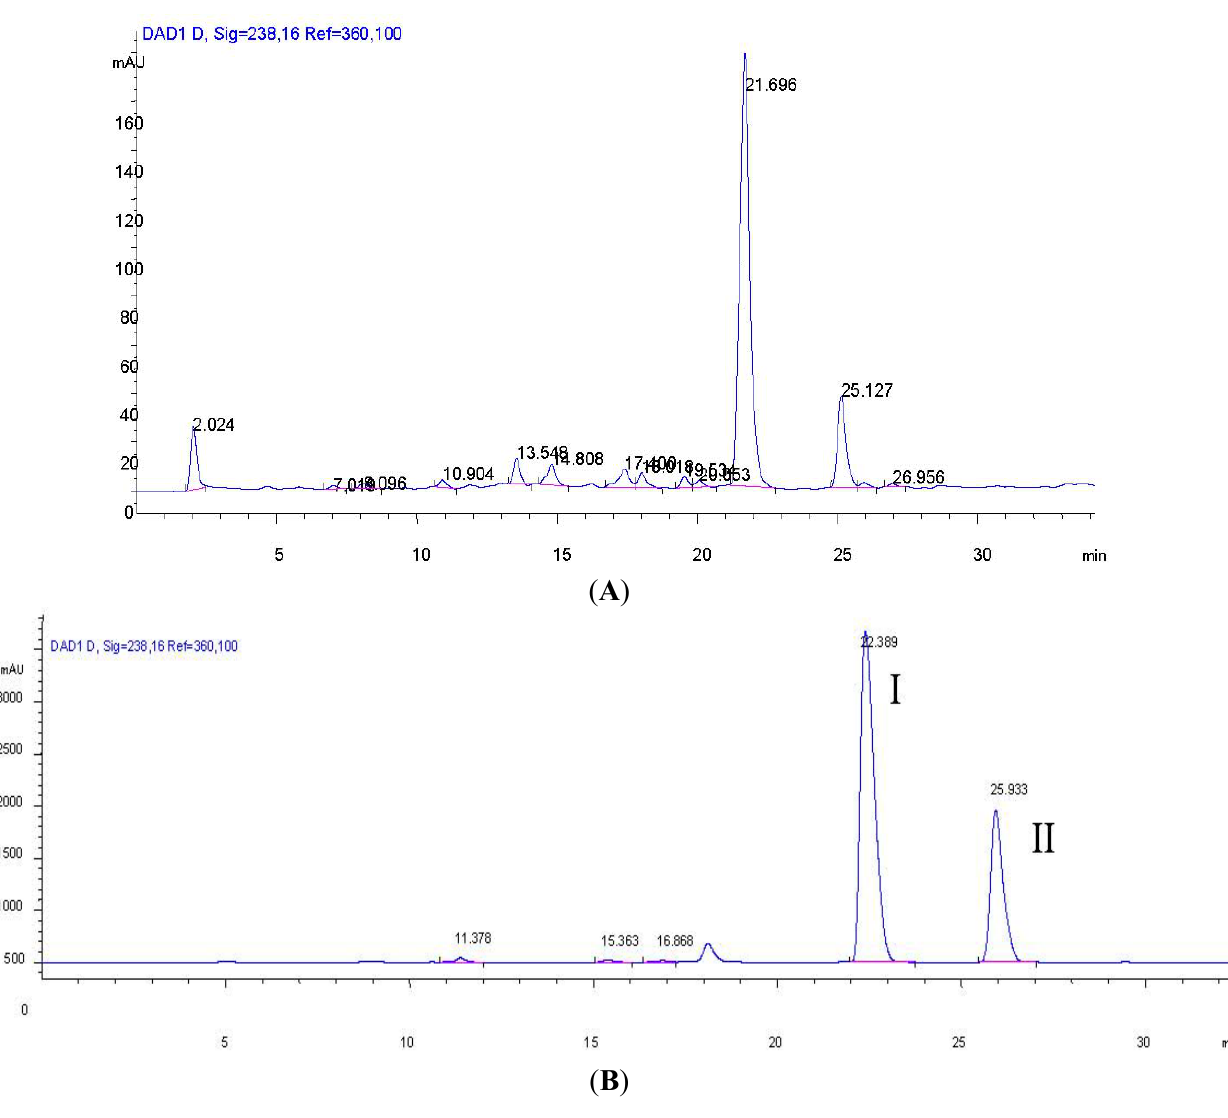
Figure 2. HPLC chromatograms of the crude extract from the whole plant of Isodon rubescens and the two targeted compounds purified by HSCCC.